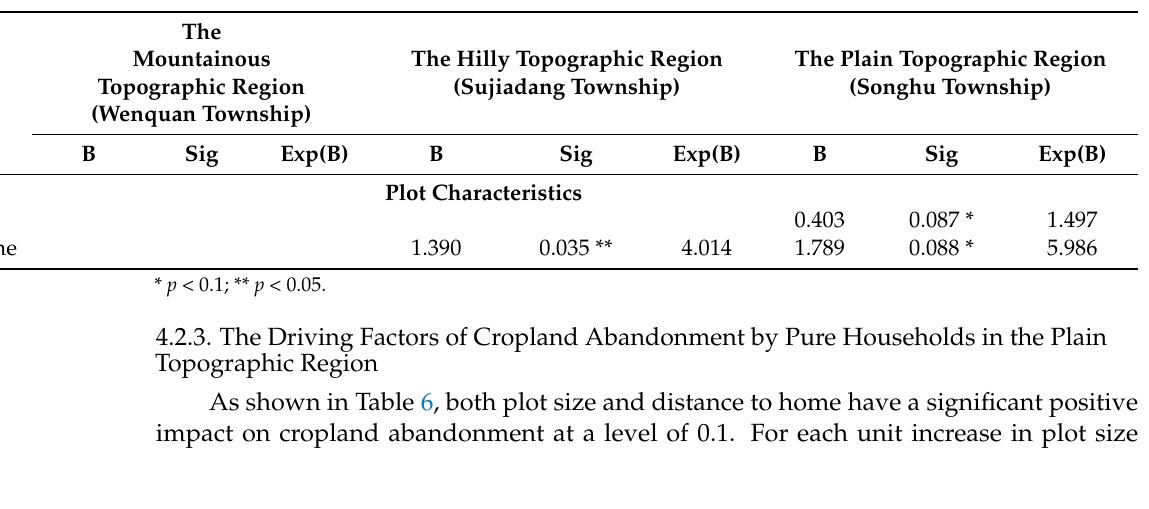
Table 6. Abandonment factors of pure households in three topographic